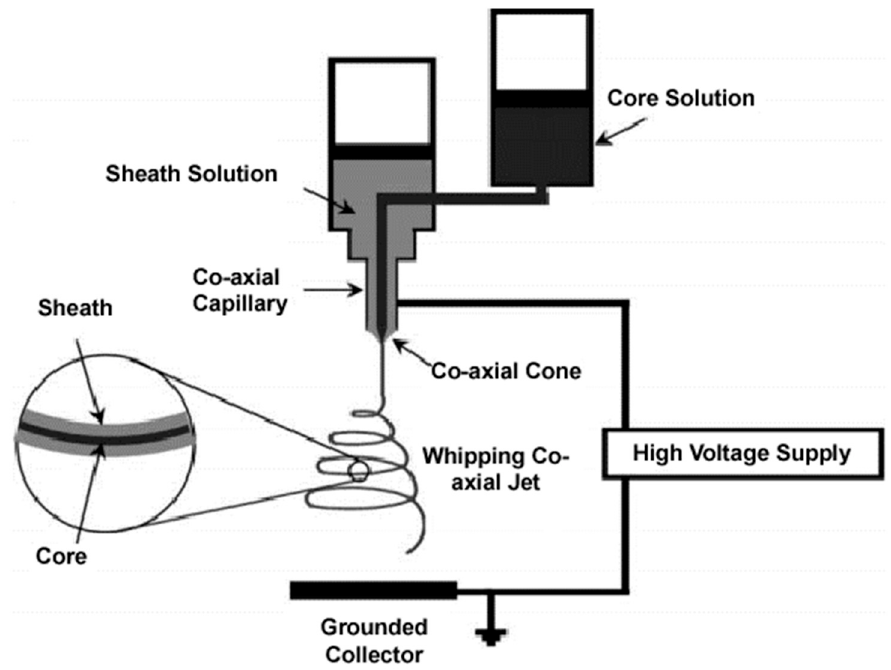
Figure 14. Scheme of coaxial electrospinning equipment and the derived core–shell fiber morphology. Reproduced with permission from [198].